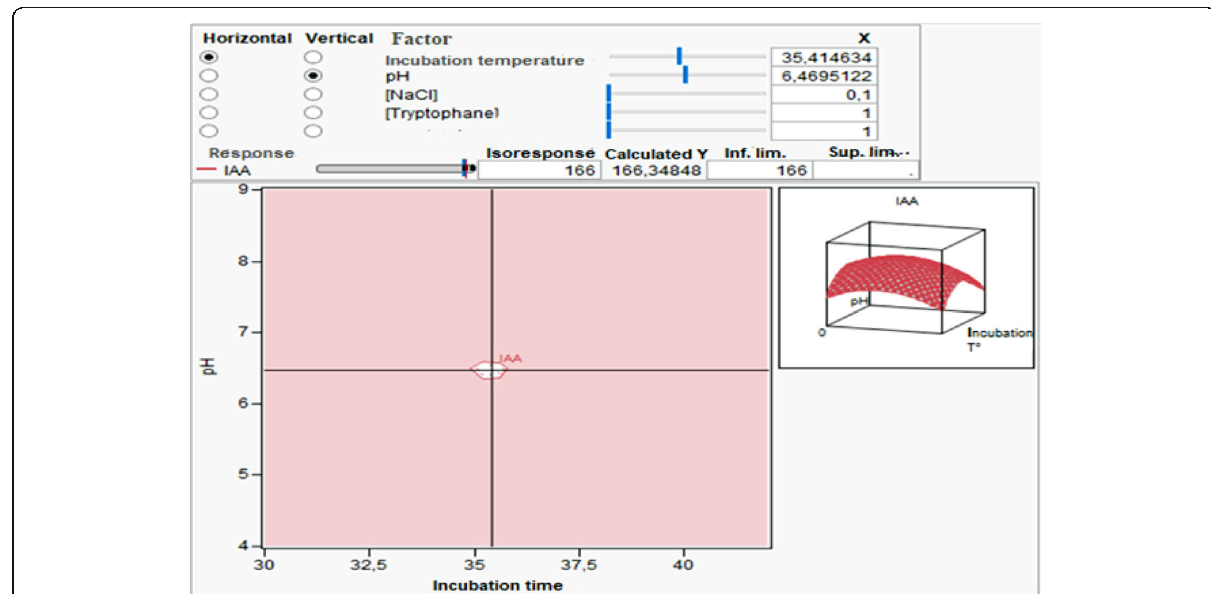
Fig. 4 Isoresponses plot for the IAA production optimization by considering both incubation temperature and pH factors and by fixing the concentrations of L-Trp at 1 g/l and NaCl at 0.1 g/l and the incubation time at 1